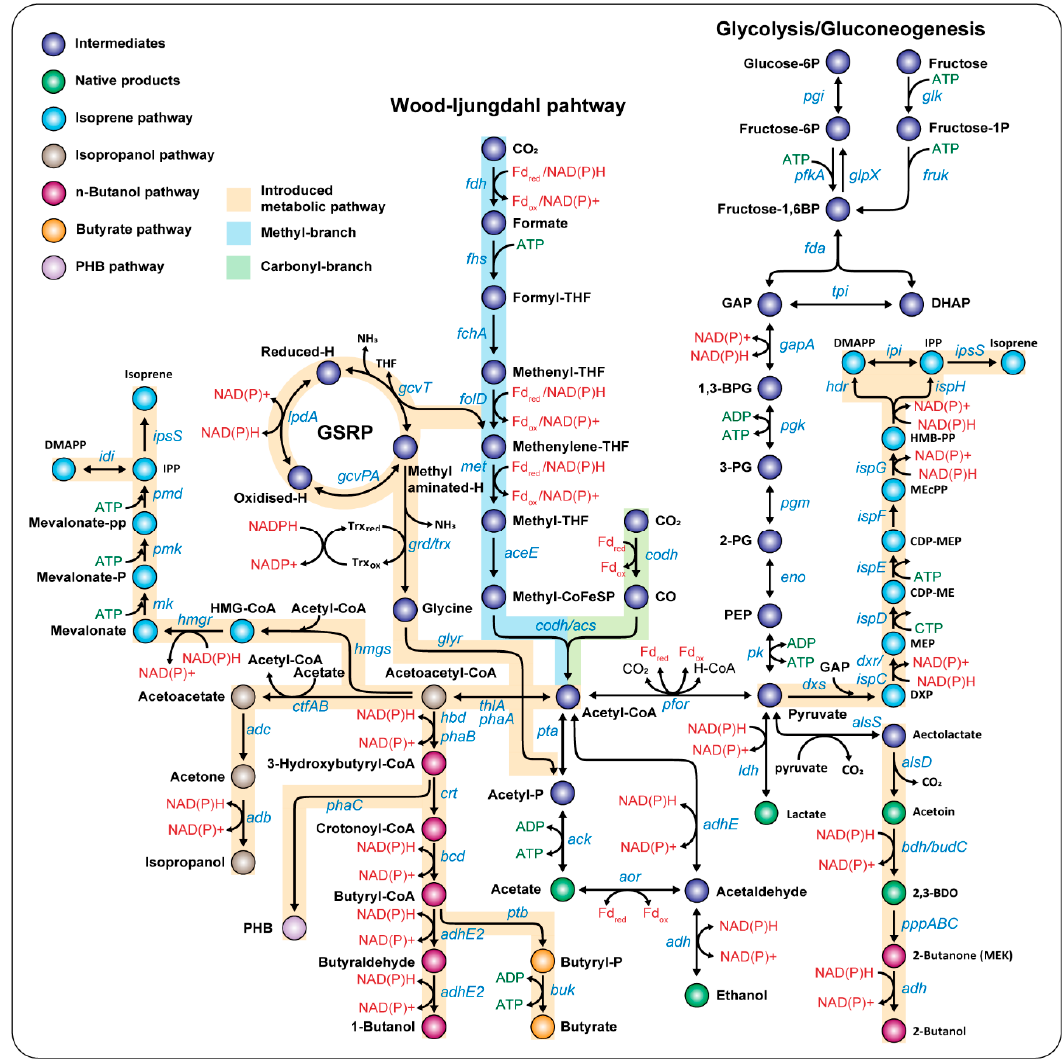
Figure 2. Metabolic pathways for engineering acetogens.